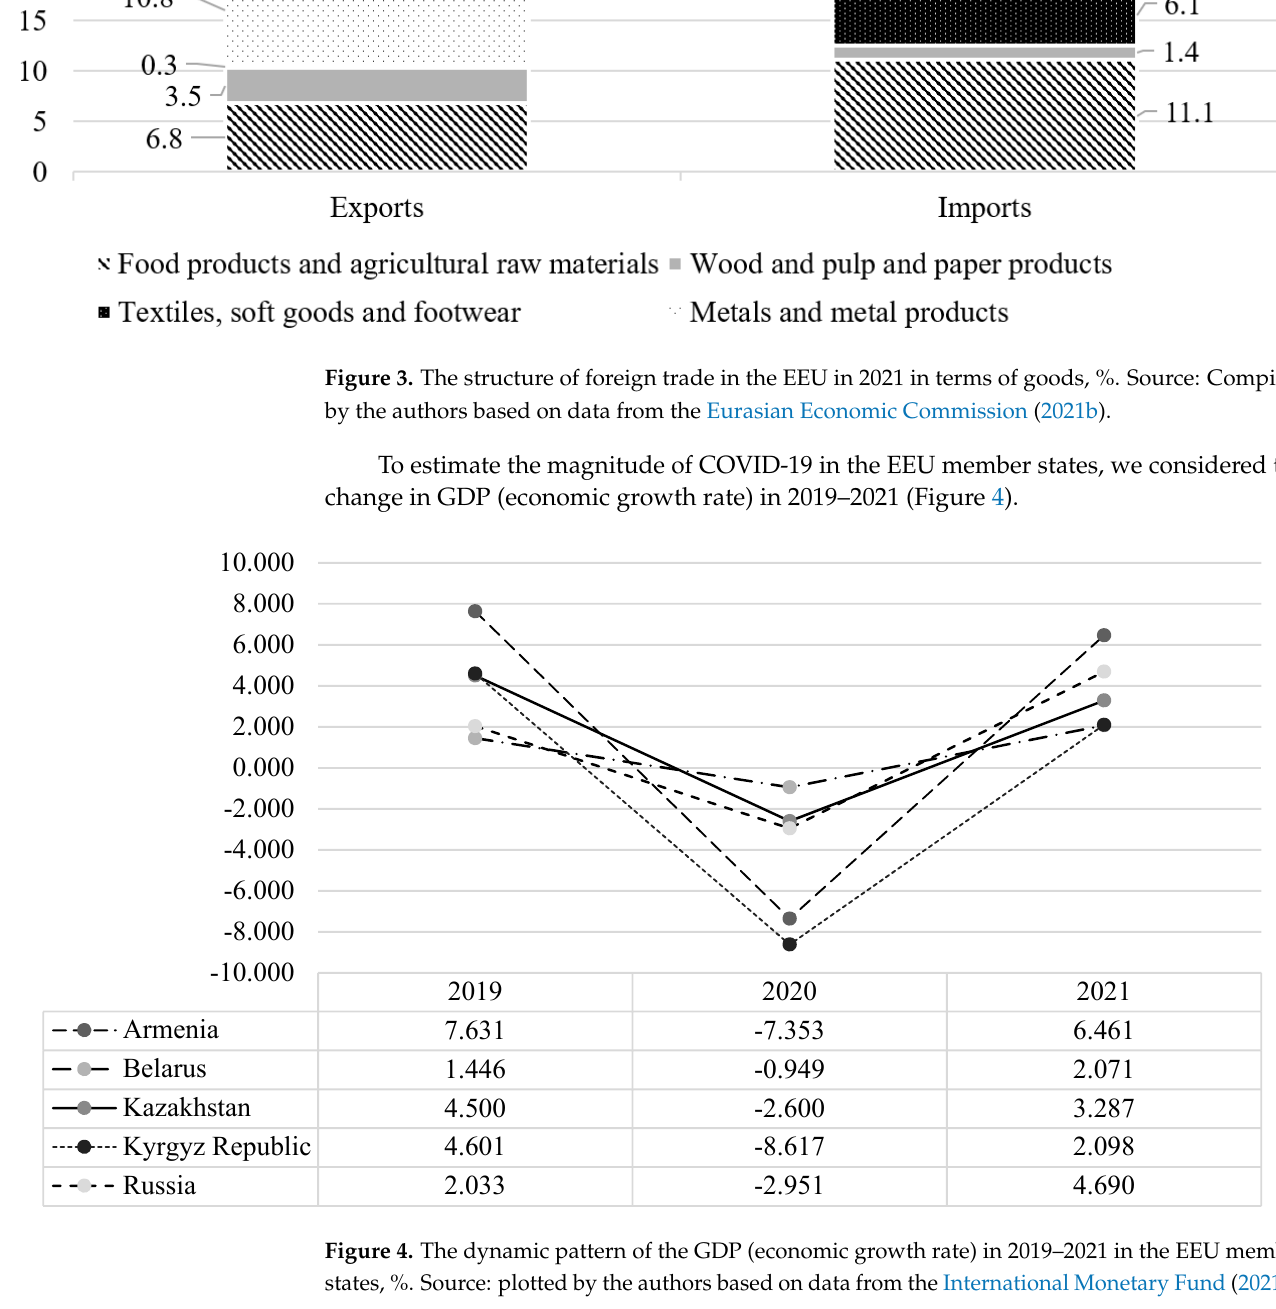
Table 6. Changes in mutual trade in goods between the third countries and the EEU member states